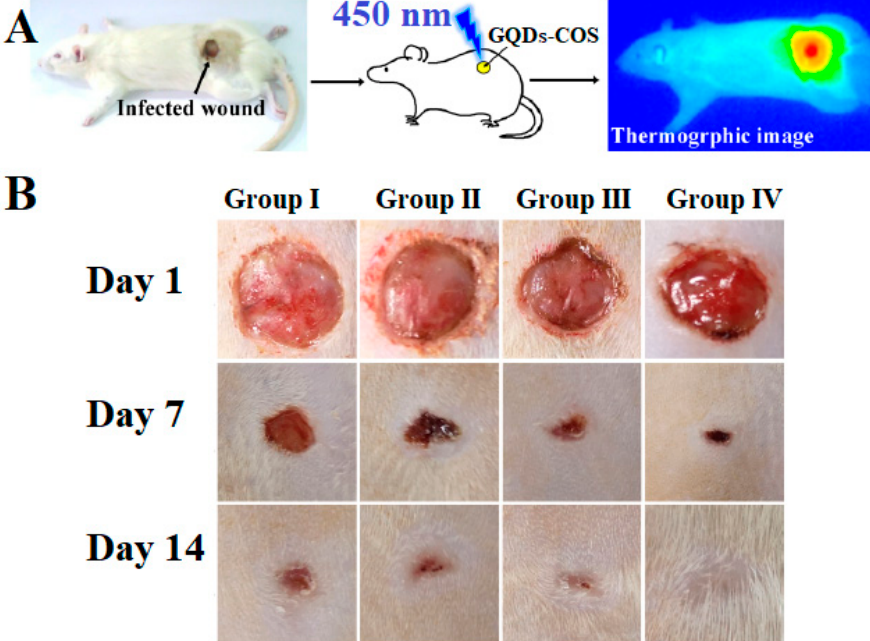
Figure 11. Image of wounds and thermographic image of wounds after treatment with GQD-Chi composite and illumination ( A ). In part ( B ), photographs of the wound at different stages are pre-